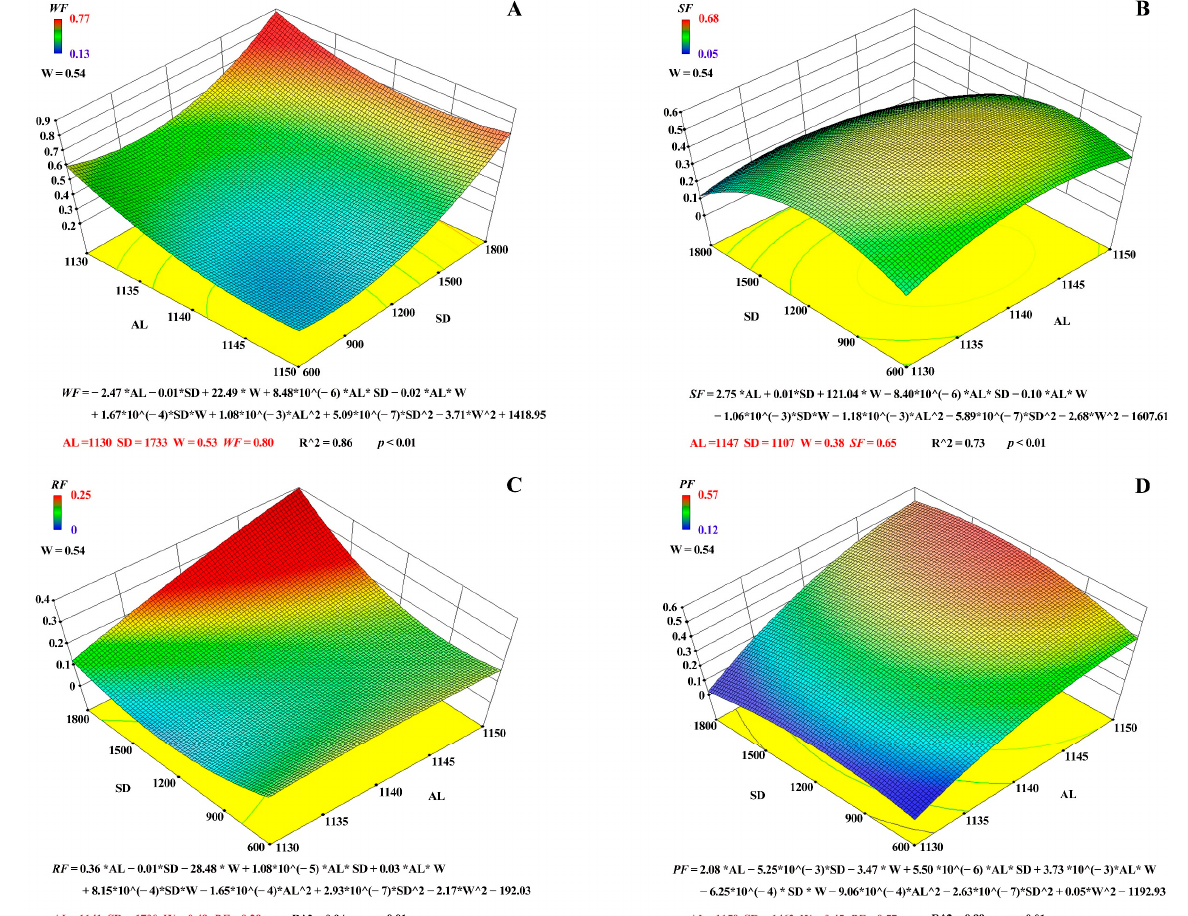
Figure 5. The multi-factor response surface models for ecological function improvement in the Pinus tabuliformis forest. Note: The multi-factor response surface models were established to enhance the WF ( A ), SF ( B ), RF ( C ), and PF ( D ). Abbreviations: WF, water-holding function; SF, soil improve- ment function; RF, function of reducing runoff and sediment yield on the slope; PF, diversity func- tion of the understory plants; AL, altitude; SD, stand density; and W, uniform angle index.